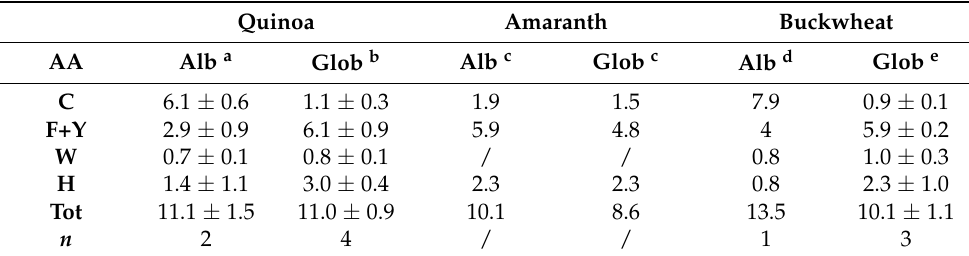
Table 1. Content of amino acids (AA) whose side chains may be involved in redox reactions. Quinoa Amaranth Buckwheat AA Alb a Glob